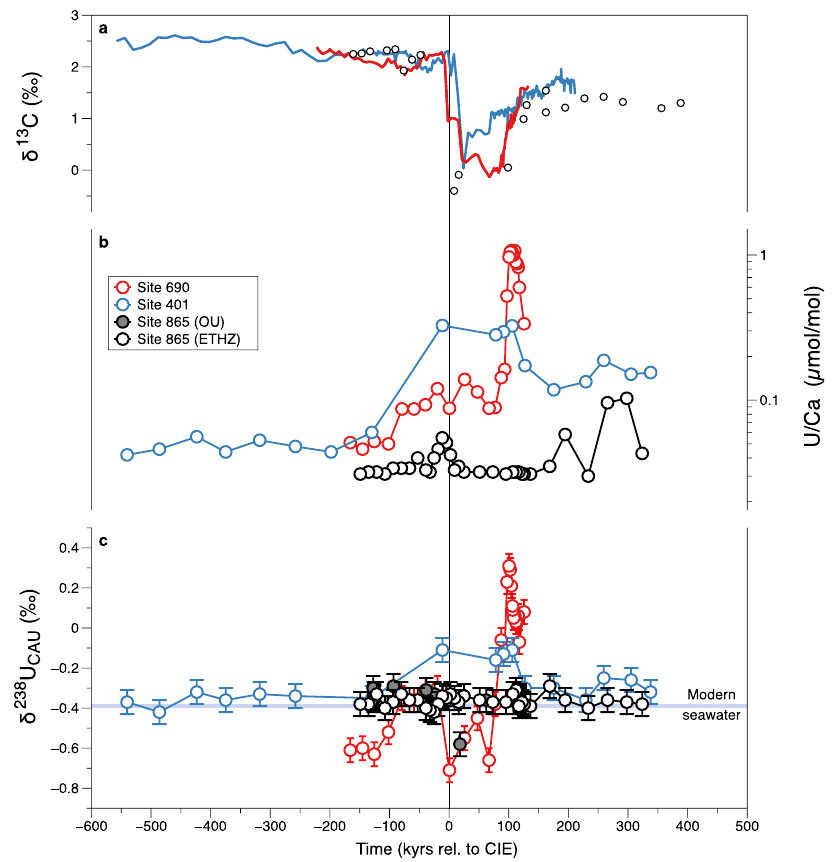
Fig. 1 Uranium isotope and U/Ca data for pelagic PETM localities. a Bulk carbonate δ 13 C data from Site 401 (blue line; ref. 1 ) and Site 690 (red line; ref. 4 ), and A. soldadoensis δ 13 C for Site 865 (black circles; ref. 53 ). All data are plotted as a function of time relative to the onset of the carbon isotope excursion (CIE) using the 3 He-based age model 68 (see “ Methods ” ). b U/Ca from carbonate leachates corresponding to δ 238 U CAU plotted in c , with symbols colored by site as in a . Note a log scale is used in b . U/Ca are not shown for samples run at the Open University (OU; gray fi lled circles) due to incomplete carbonate digestion (see “ Methods ” ). Error bars for δ 238 U CAU ( c ) represent the external reproducibility of the NIST-SRM 1d limestone standard (±0.06 ‰ , 2 SD, n = 14; see “ Methods ” ). PETM δ 238 U CAU data are compared to average modern δ 238 U sw in c ( − 0.39 ± 0.01; blue shading) 28